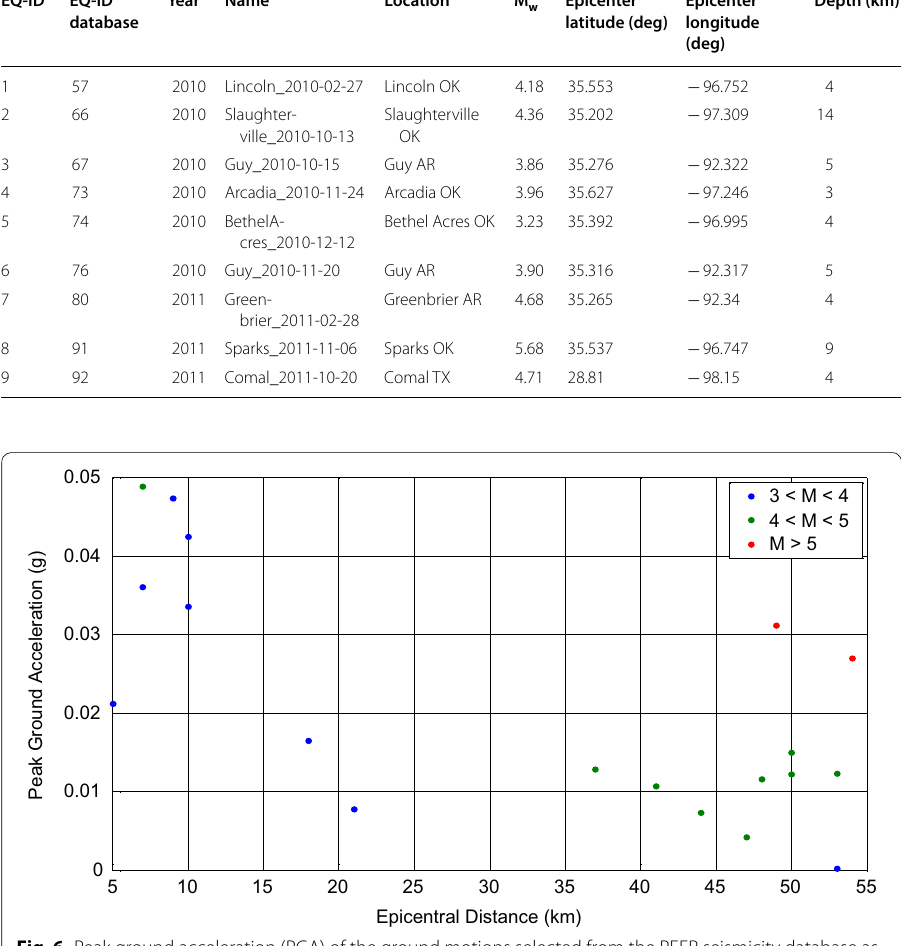
Fig. 6 Peak ground acceleration (PGA) of the ground motions selected from the PEER seismicity database as a function of epicentral distance (the data are based on the availability of seismic stations in PEER database that recorded each event in the range of epicentral distance considered in this